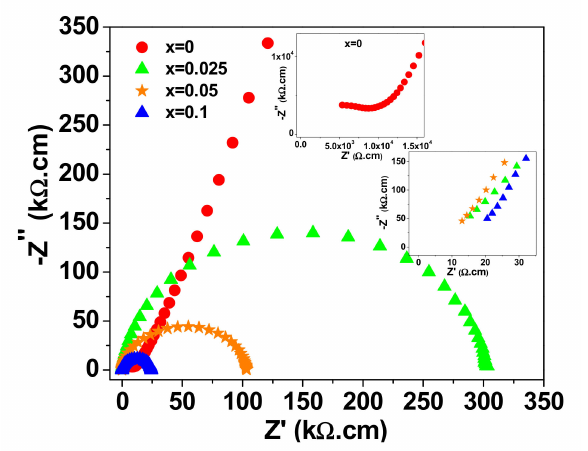
Figure 5. Impedance complex plane plot (Z*) at room temperature for NSTO ceramics. Table 2. The room temperature values of grain resistivity (R g ), grain-boundary resistivity (R gb ), ε (cid:48) and tan δ at 1.1 kHz and the minimum dielectric loss value (tan δ ) min for NSTO ceramics. R g ( Ω .cm) R gb ( Ω